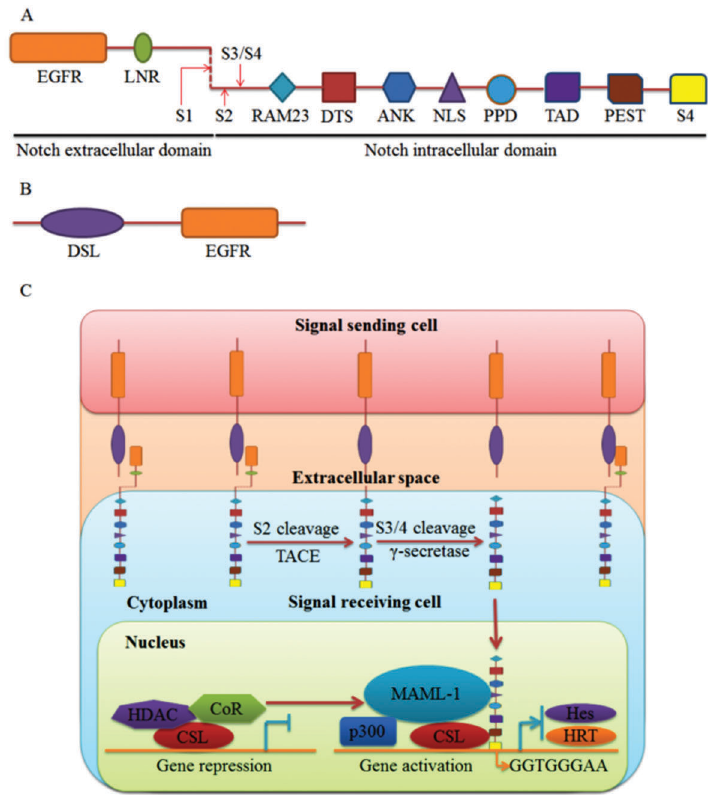
extracellular and intracellular domains. The extracellular domain consists of EGFR and LNR. The intracellular domain contains RAM23, DTS, ANK, NLS, PPD, TAD, PEST, and S4. The red arrows indicate cleavage sites: S1 (Furin), S2 (TACE), and S3/S4 ( c -secretase). B , Notch ligands have DSL and EGFR domains. C , Notch signaling transduction pathway ligand- receptor interaction leads to two successive cleavages at S2 by TACE and S3/4 by c